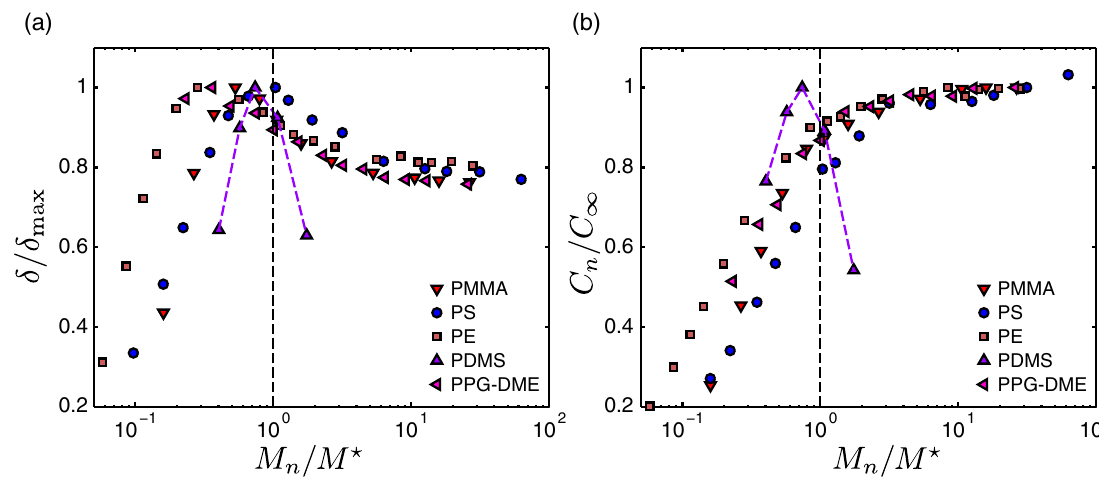
FIG. 8. (a) Calculated non-Gaussianity δ as a function of normalized molecular weight δ ð M=M ⋆ Þ , normalized by the maximum value δ from RIS simulations for PMMA, PS, PE, PDMS, and PPG-DME, where M ⋆ is determined by the scaling in Fig. 2. (b) Calculated max characteristic ratio C as a function of normalized molecular weight, normalized by C ∞ , which we take as the high- M maximum value n ≃ C C max ∞ (for PS, the maximum value is taken as the average of the three highest M data points). The data for PDMS are qualitatively n different from those of the other polymers because of its unusual ground-state-energy loop structure; hence, a dashed line has been added to the PDMS data as a guide to the